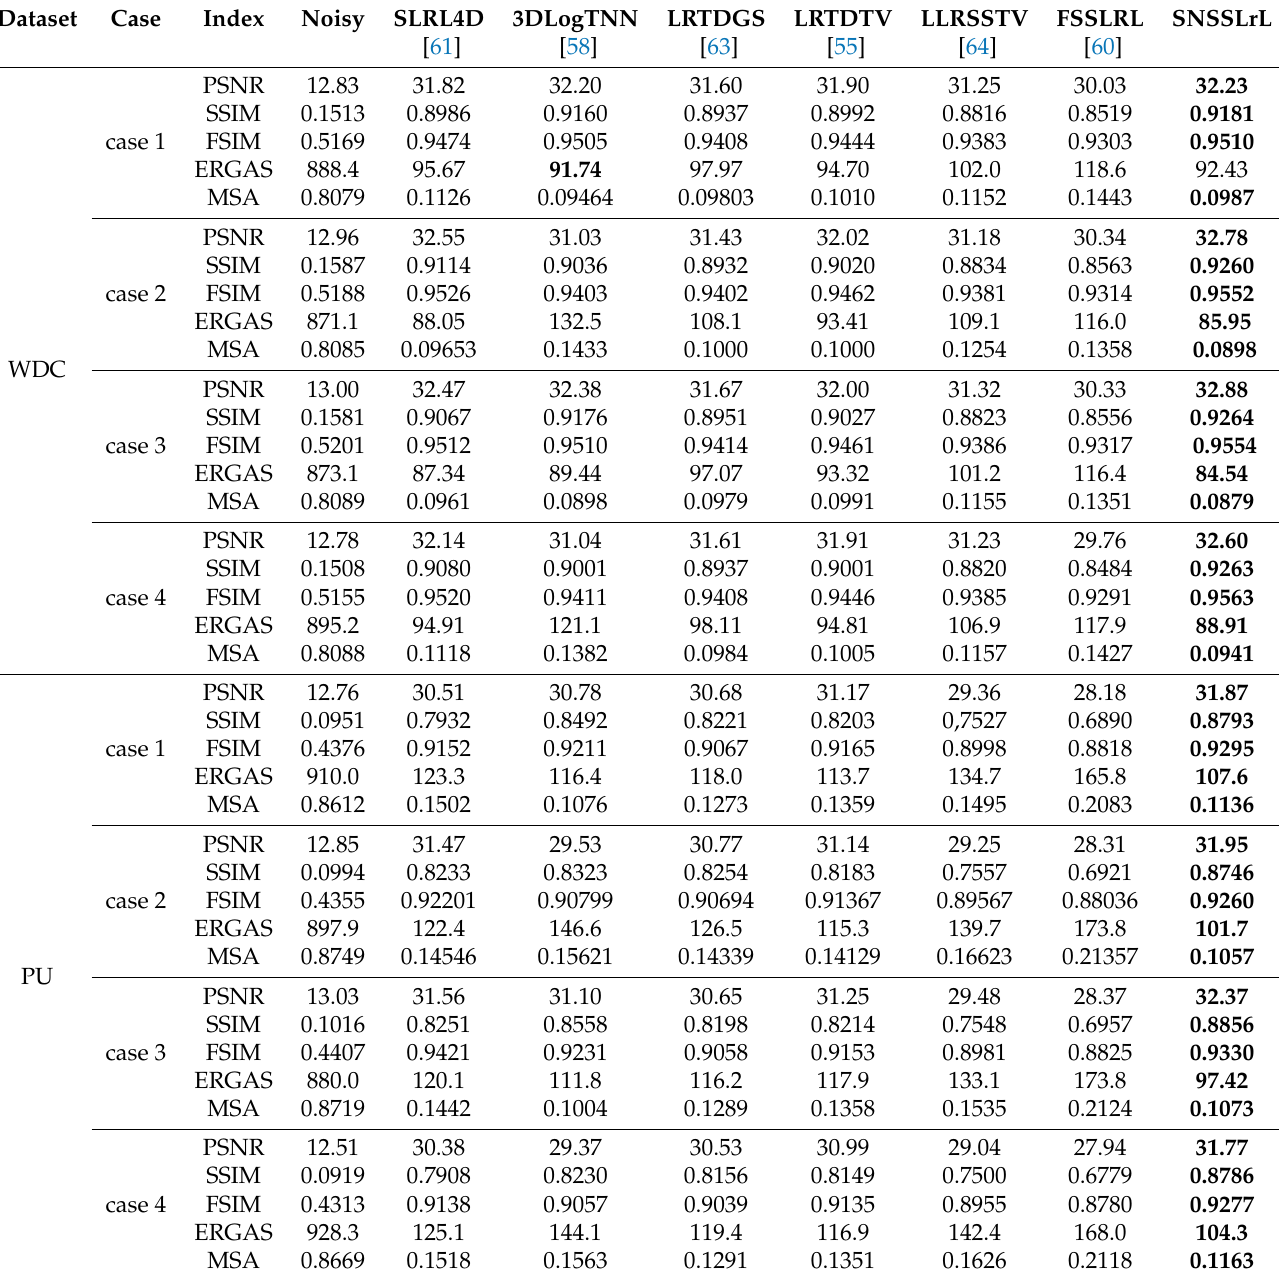
Table 2 lists the quantitative denoising results of the above seven algorithms in four cases on the WDC and PU datasets, with a total of five indicators. For case 1 of WDC, the PSNR value of SNSSLrL is 0.03 dB higher than the second-place 3DLogTNN method, while the ERGAS value is 0.69 higher (the lower the ERGAS value, the better the algorithm performance). For the other cases of the two datasets, the proposed SNSSLrL method has achieved the best quantitative results on the five indicators. For example, for case 4 of PU data, the proposed SNSSLrL method achieves a PSNR value of 0.78 dB higher than the second place LRTDTV method. In conclusion, whether it is simple Gaussian noise and impulse noise or complex mixed noise, the proposed SNSSLrL method achieves the best results in all terms of visual effects and quantitative evaluation of HSI recovery compared to all six competitors. Table 2. Quantitative results under all four different simulated case (the optial results are highlighted in bold).